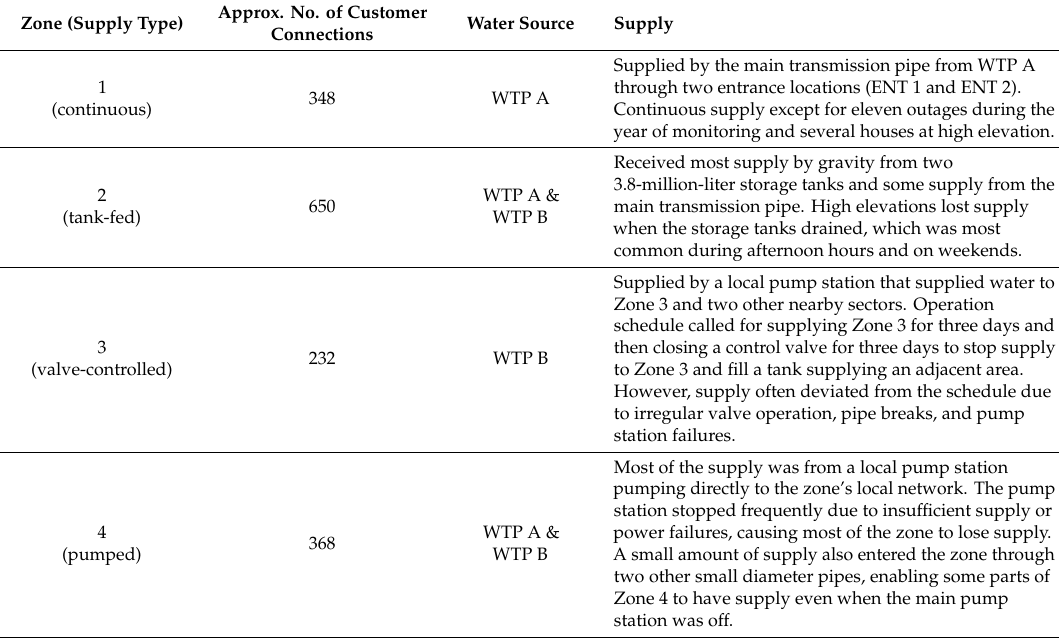
Table 2. Summary of study